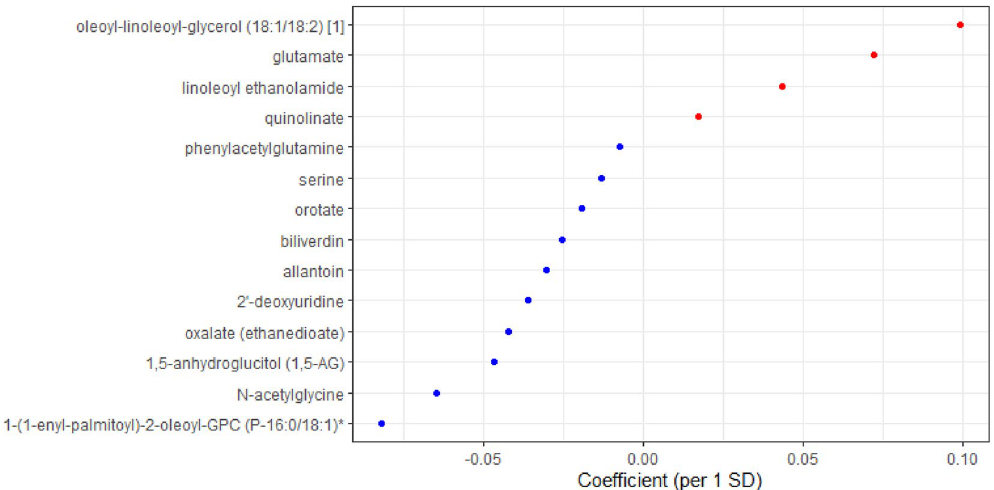
Figure 3. Coefficients for metabolites selected by LASSO (OSA model) in HCHS/SOL. Blue: coefficient < 0; Red: coefficient > 0. OSA moderate to severe obstructive sleep apnea (AHI ≥ 15), LASSO least absolute shrinkage and selection